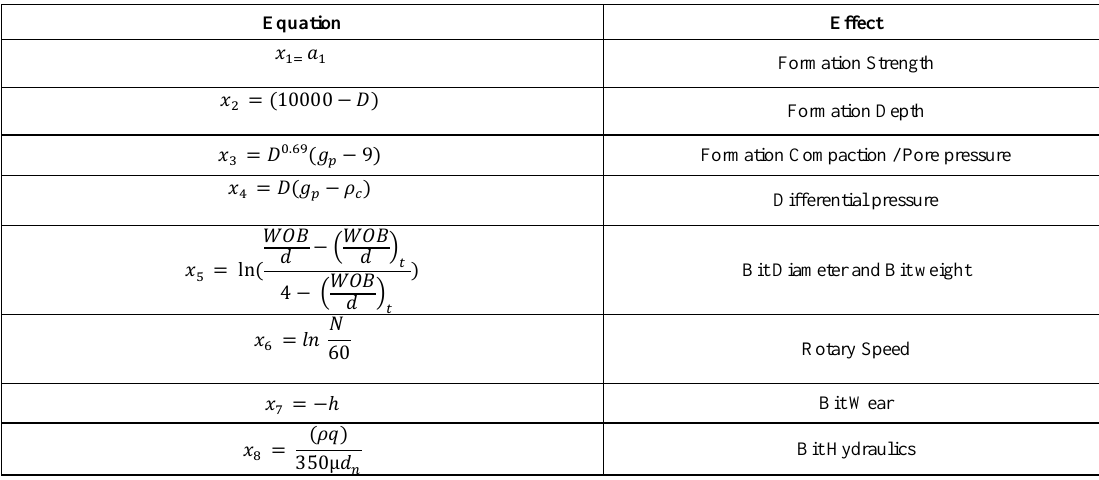
Table 1. Bourgoyne and Young